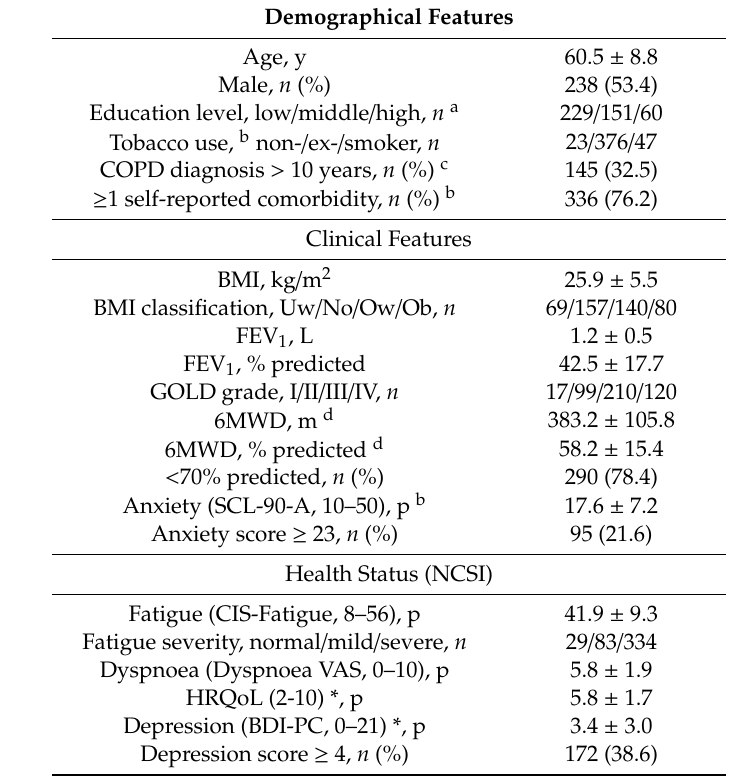
Table 2. Baseline characteristics of all eligible chronic obstructive pulmonary disease (COPD) patients referred for pulmonary rehabilitation (PR) ( n =